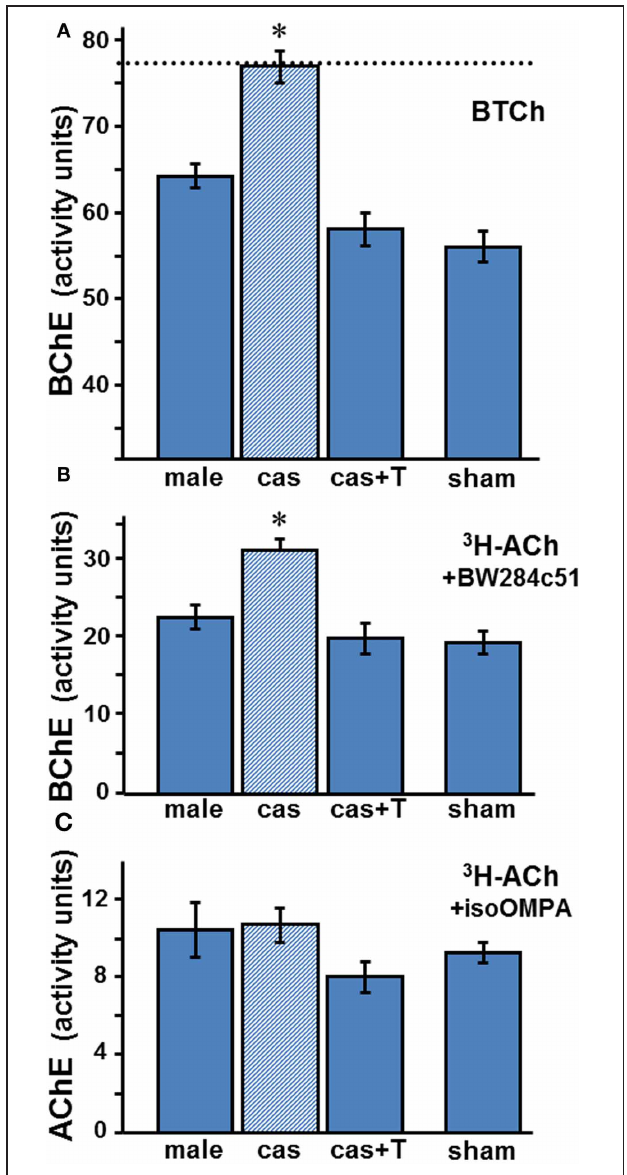
FIGURE 3 | Effect of orchidectomy and T-replacement appears to be on BChE, not on AChE. Activities in wt sera of BChE (A,B) and AChE (C) were determined colorimetrically (A) or radiometrically (B,C) with appropriate substrates and selective inhibitors as described in the legend to Figure 2 . Values are the mean ± SEM for 6–8 samples per group (sham group, n = 3). BChE levels in gonadectomized animals (dashed line in A ) differ significantly from those in intact, T-treated and sham animals: Data were analyzed by One-Way ANOVA, showing statistical significance in A ( p (cid:6) 0 . 0002) and in B ( p (cid:6) 0 . 0001), with Tukey’s post-hoc revealing significant differences ( ∗ ) between castrated male (cas, shaded column) and the other three groups: intact male (male) ( p < 0 . 0003), castrated with T-replacement (cas + T) ( p < 0 . 0002) or sham ( p < 0 . 0002). All other comparisons showed insignificance ( p > 0 . 05): male compared to cas + T ( p = 0 . 086), or to sham ( p = 0 . 07), and cas + T compared to sham ( p = 0.92). Similarly, post-hoc test in B showed significant difference between cas and the other groups: male ( p < 0 . 001), cas + T ( p < 0 . 0004), and sham ( p < 0 . 001), which were very similar. No significant changes were observed in AChE activity (C)